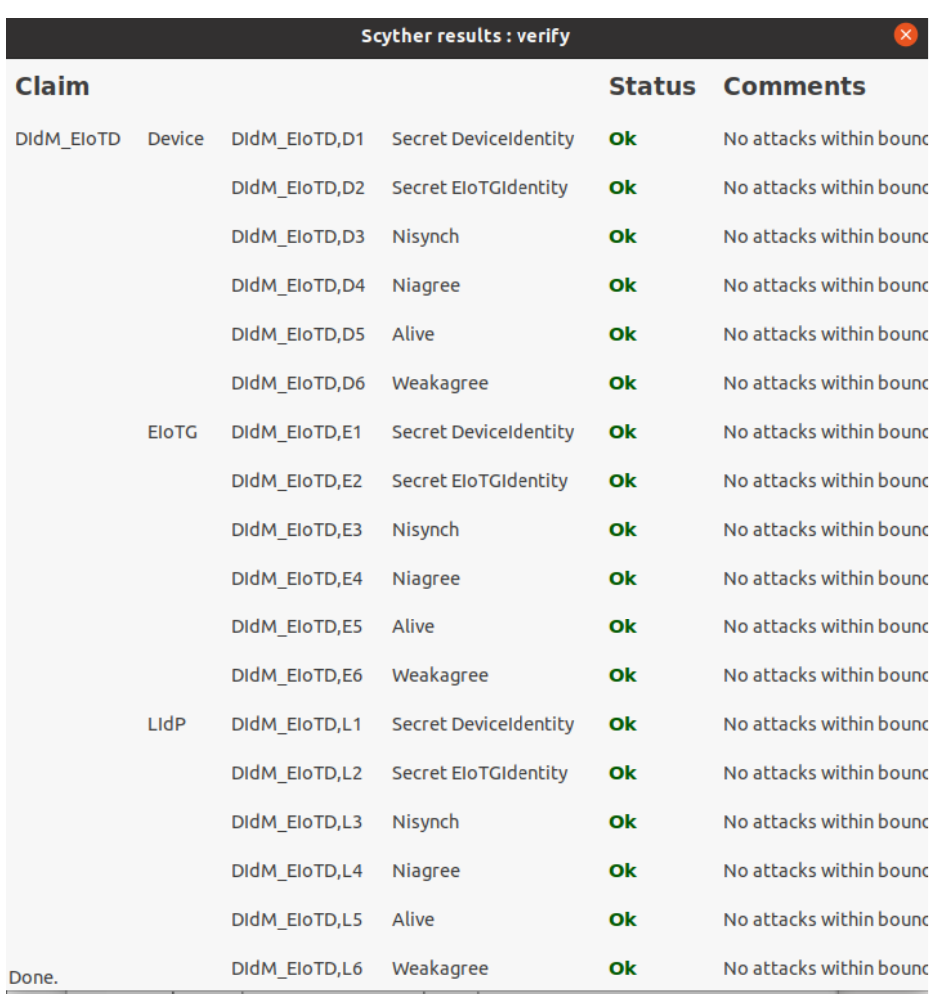
Figure 14. Scyther verification results for interaction between Device, EIoTG and LIdP.